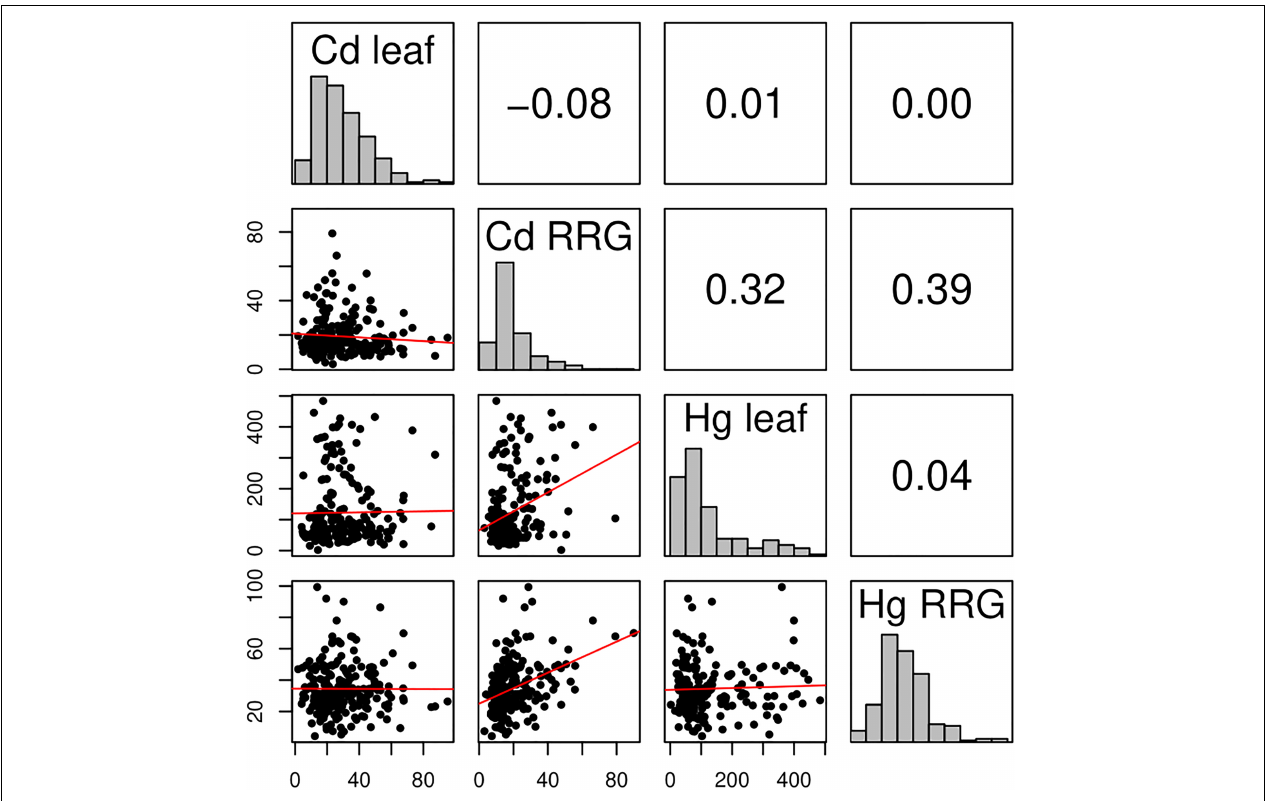
FIGURE 1 | Correlation matrix of Cd leaf accumulation, Cd relative root growth (RRG), Hg leaf accumulation, and Hg relative root growth (RRG) measured in the M. truncatula HapMap panel. Distributions of the four phenotypes are shown in the diagonals. The upper, off-diagonal panels contain pairwise Pearson’s correlation coefficients ( r ). Lower, off-diagonals are the plotted trait values of each M. truncatula genotype measured in our experiment. The red line shows the slope of the correlation between any pair of traits. The x - and y -axes are values of the phenotype measurements [in µ g − 1 dry weight for leaf, and percent for relative root growth